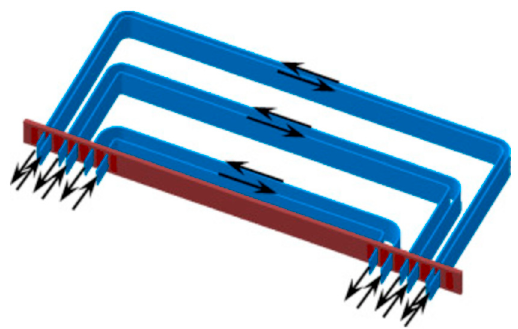
Figure 8. Helium flow direction in the Cooling Plates (CPs).